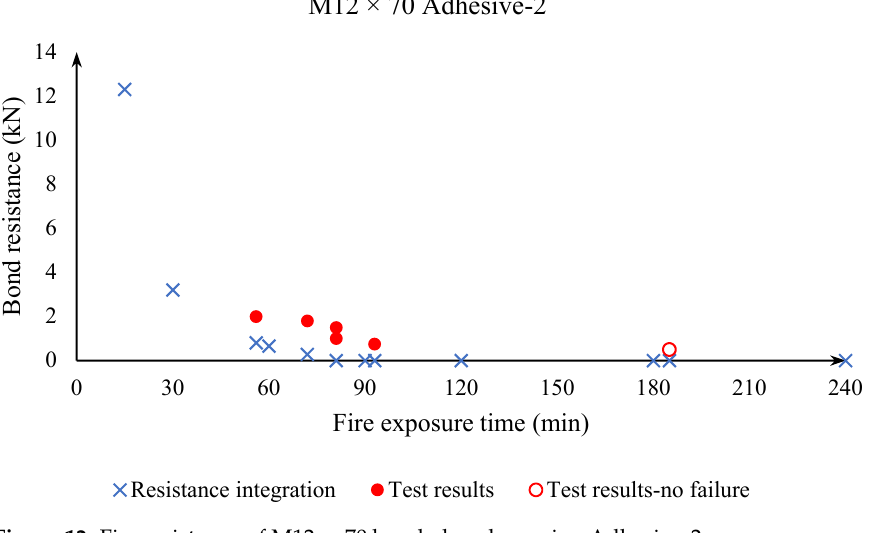
Figure 12. Fire resistance of M12 × 70 bonded anchor using Adhesive-2.